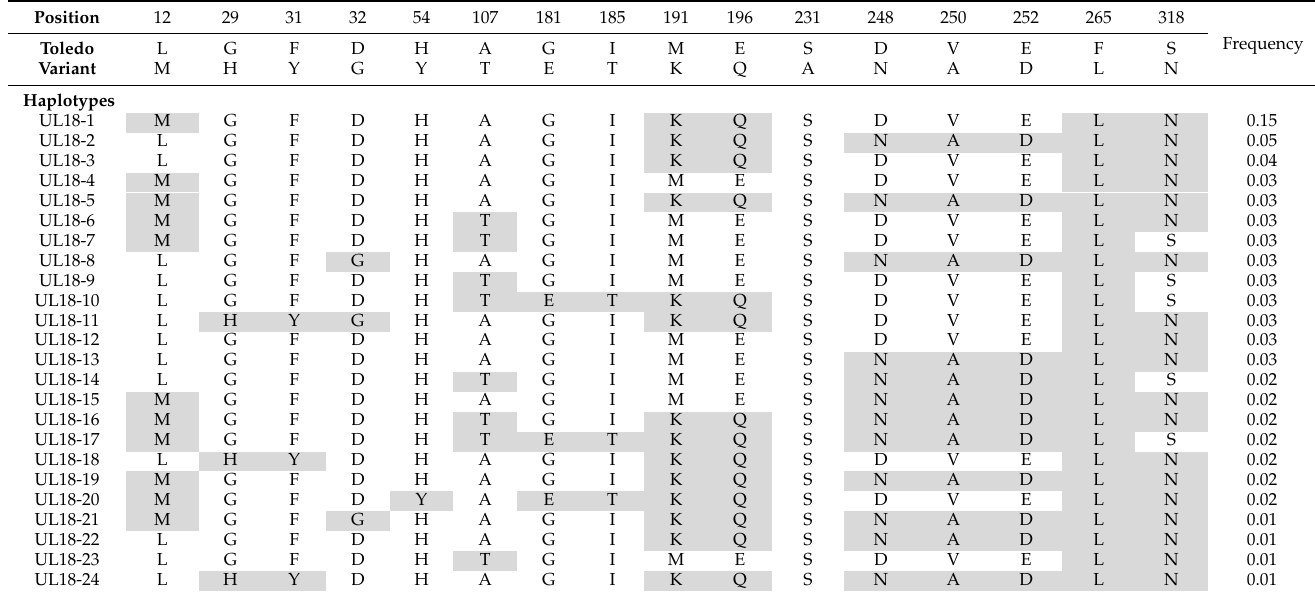
Table 5. Several UL18 variants are frequently carried